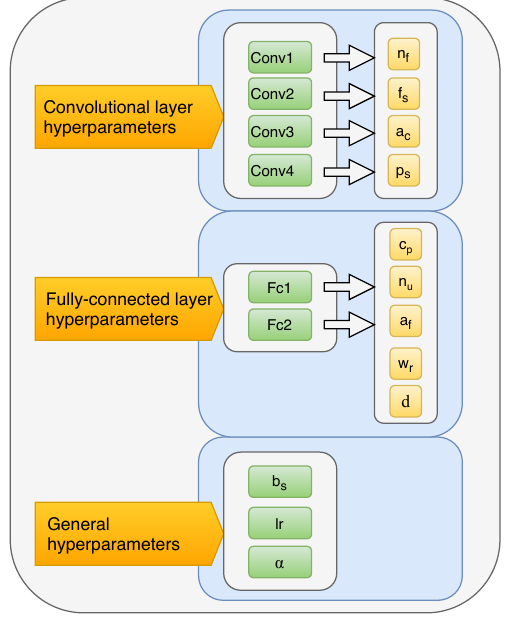
Figure 4. CNN structure encoding